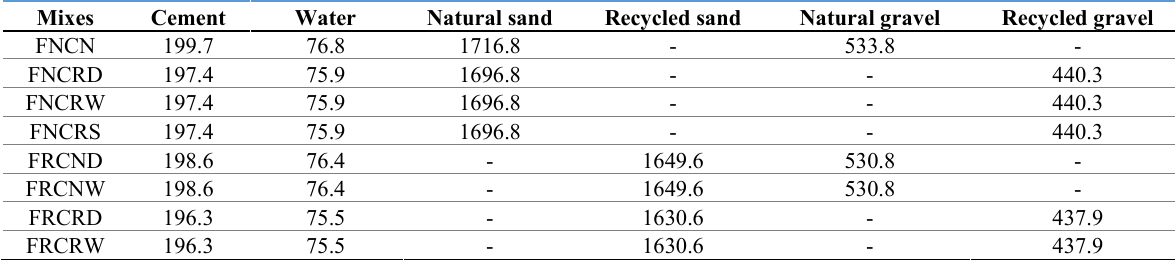
Table 3. Mix proportions of concrete